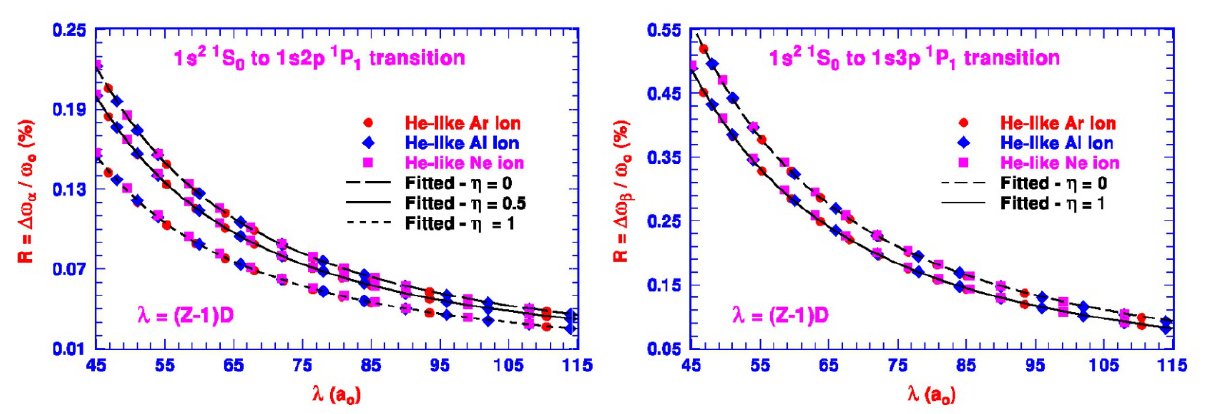
Figure 2. The universal behavior of the calculated R as functions of the reduced Debye length λ for three He-like ions and their comparison to the fit ratio R given by Equation (17) with the coefficients given in Table